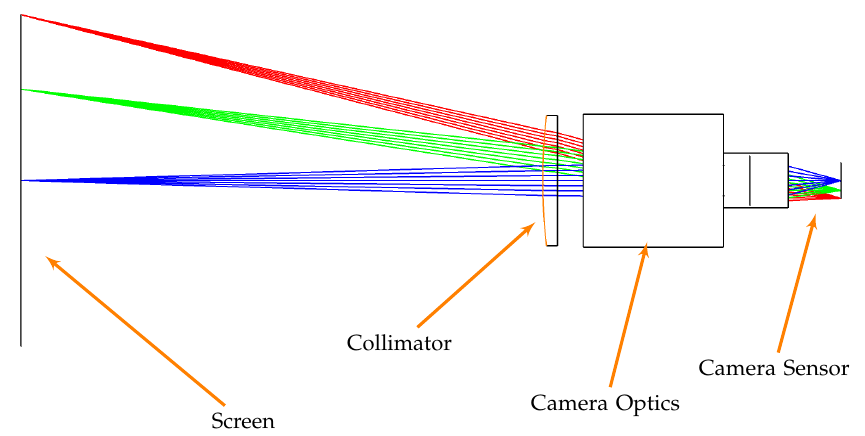
Figure 7. A Zemax ® model of TinyV3RSE with the camera focused at infinity. Ray colors are associated with the screen-emitting